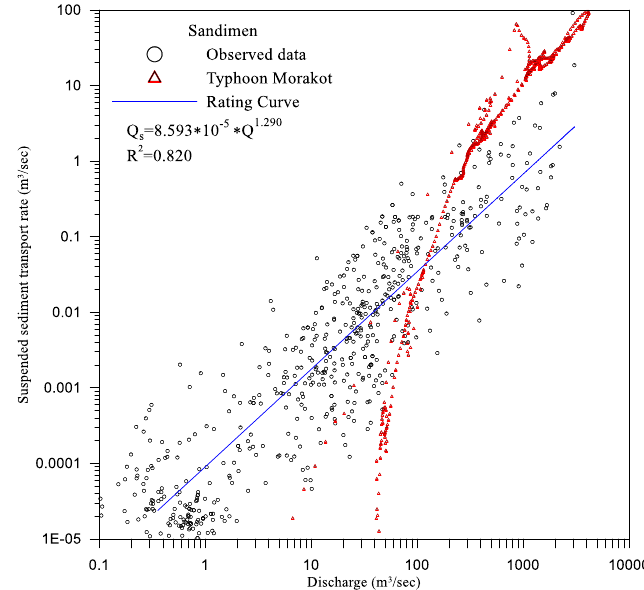
Figure 14. Simulated and observed relationship between flow discharge and sediment transport rate at Sandimen Bridge station.